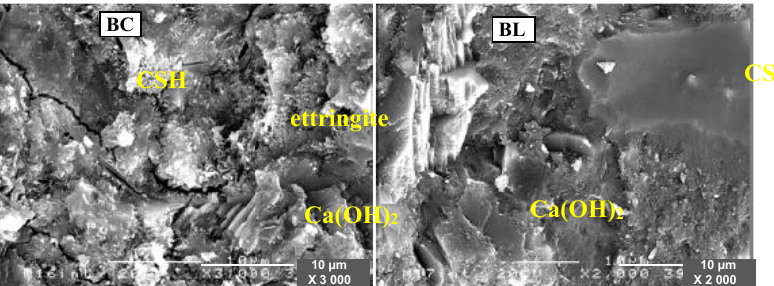
Fig. 7. SEM observation of the internal micro-structure of concrete specimens after 365 days of